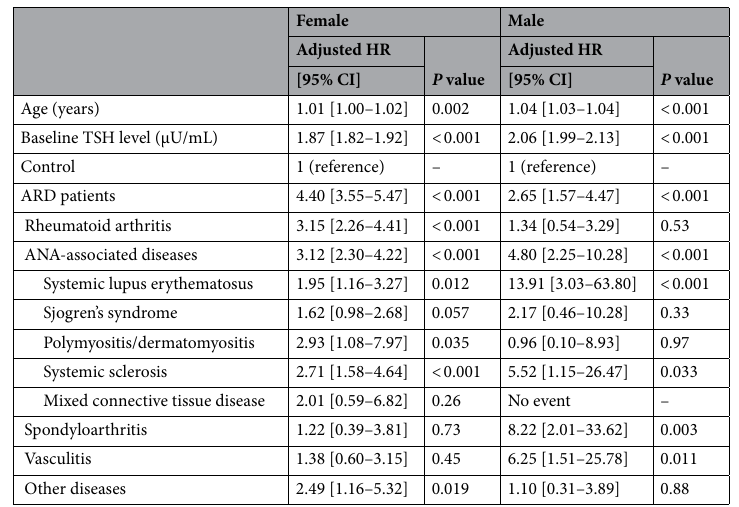
Table 4. Hazard ratio of autoimmune rheumatic diseases for hypothyroidism requiring treatment during follow-up stratified by sex. HR hazard ratio, CI confidence interval, TSH thyroid-stimulating hormone, ANA antinuclear antibody.